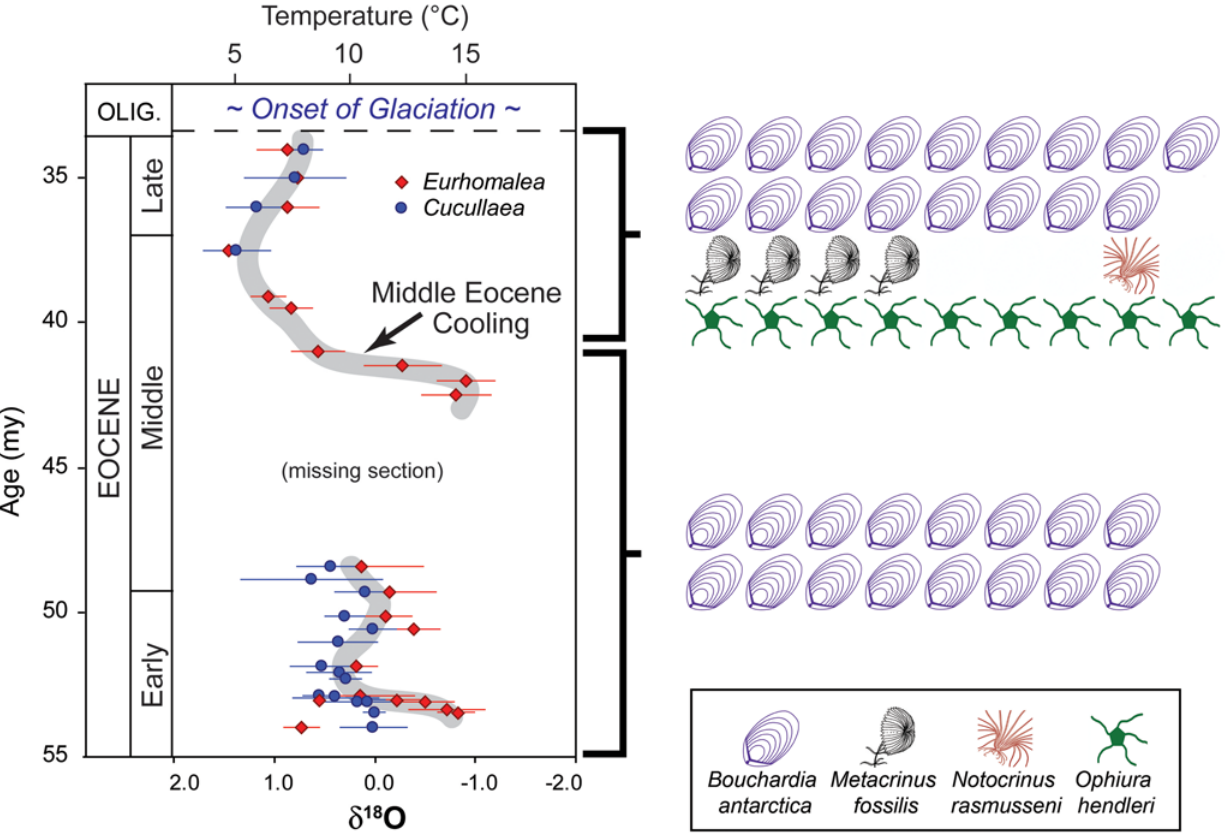
Figure 1. Distribution of epifaunal suspension-feeders in Telms 2–7 of the La Meseta Formation at Seymour Island, below and above the cooling event at 41 Ma. Graph on the left shows the Eocene paleotemperature curve derived from the La Meseta Formation at Seymour Island, based on mean oxygen-isotope values of shell material from two bivalve genera. Error bars represent standard deviations. Ages of horizons and the inferred presence of a middle Eocene unconformity are based on strontium-isotope stratigraphy (redrawn from [10]). Icons on the right denote dense, autochthonous or parautochthonous fossil concentrations that represent abundant paleopopulations of rhynchonelliform brachiopods, Bouchardia antarctica ; stalked crinoids, Metacrinus fossilis ; unstalked (comatulid) crinoids, Notocrinus rasmusseni ; and ophiuroids, Ophiura hendleri . Paleontological data are based on surveys conducted in 1986, 1994, 2000, and 2001.